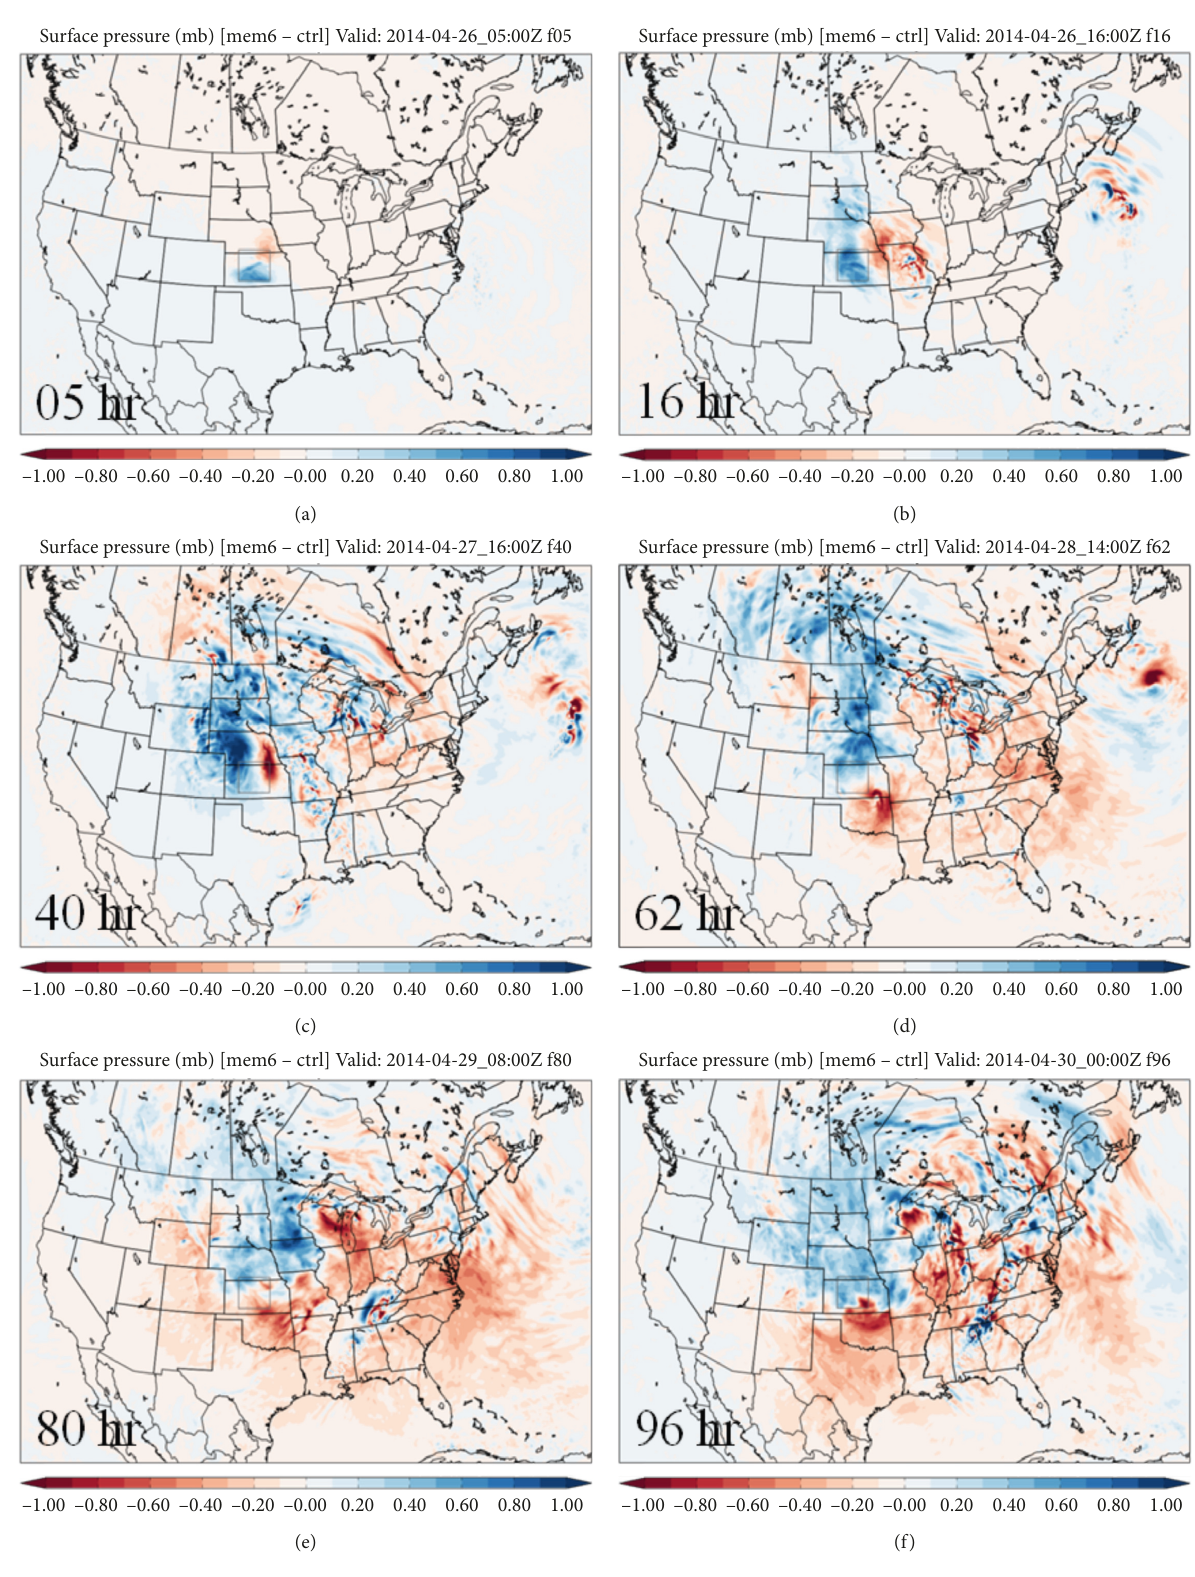
Figure 10: Surface pressure perturbations at forecast hours 05 (a), 16 (b), 40 (c), 62 (d), 80 (e), and 96 (f) for the 26 April 2014 case due to a wind farm in box shown in